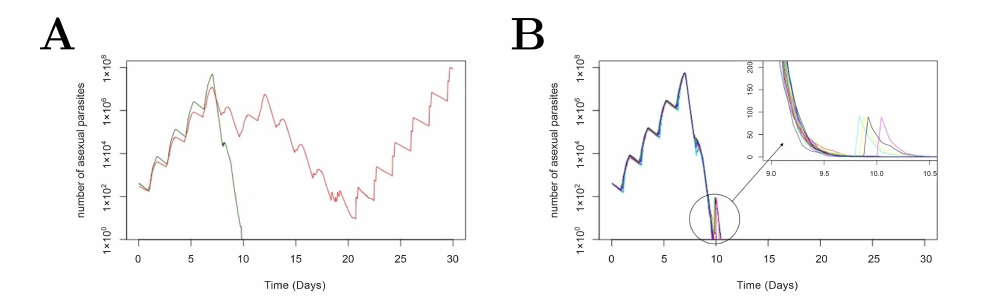
Figure 2. Examples of stochastic model trajectories. ( A ) shows two examples of extinction (green) and recrudescence (red). To mimicking the VIS clinical trial, for the extinction simulation, the parameter values used are P init = 440, µ = 4.0, σ = 5.5, r p = 92, k max = 0.24, EC 50 = 3.0, γ = 7.0, f = 0.0047, δ p = 0.035 and PK curve C ( t ) is obtained from Cao et al. (Volunteer 101). For the recrudescence simulation, we used P init = 0.11, µ = 6.0, σ = 5.3, r p = 76, k max = 0.12, EC 50 = 13, γ = 11, f = 0.0088, δ p = 0.038, and PK curve C ( t ) is obtained from Cao et al. (Volunteer 102). All the parameter values are chosen based on the posterior estimates from [9]. ( B ) shows 30 more realisations of stochastic extinction using the same parameter values as that generating the green curve in ( A ). A close-up is shown on the top-right corner.